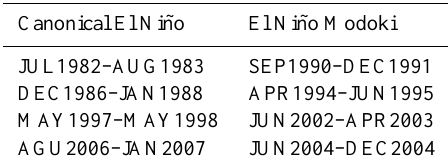
Table 1. Samples of canonical El Ni˜no (left column) and El Ni˜no Modoki (right column) events from 1980 to 2010 analyzed in this